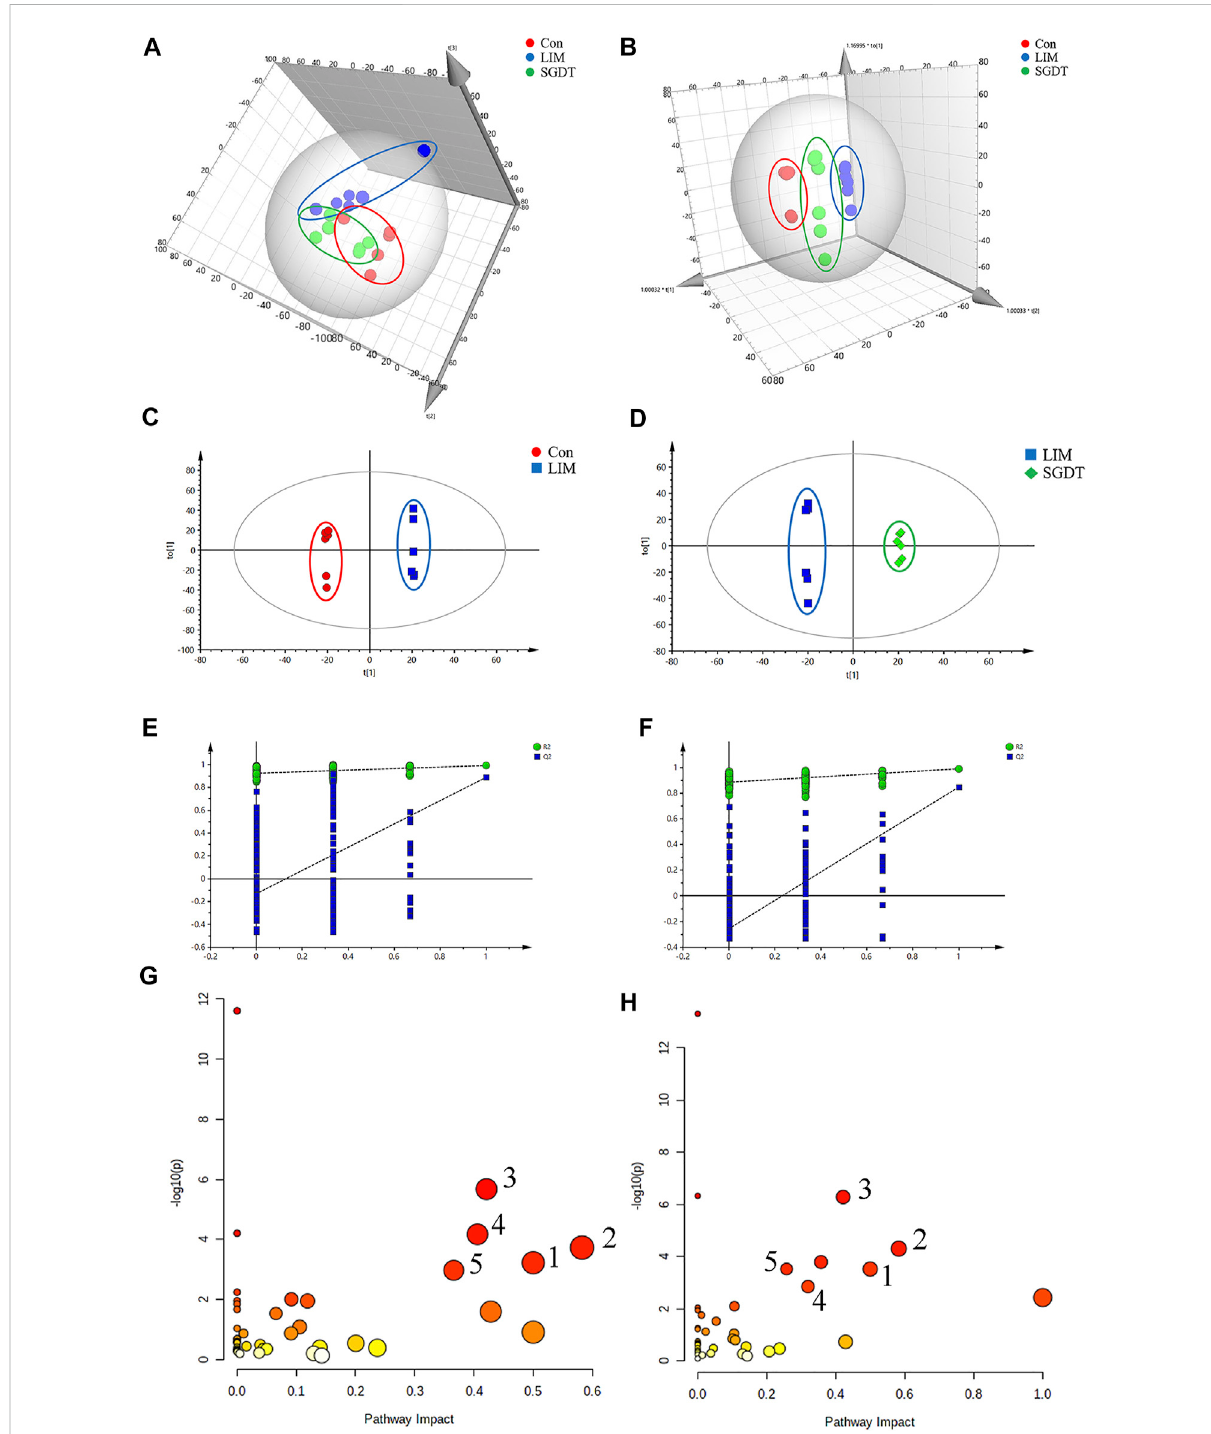
FIGURE 3 Fecal metabolite pro fi ling based on 1 H NMR spectrum of fecal samples, and metabolic pathways. (A,B) PCA and OPLS-DA score plots of Con, LIM and SGDT. (C,D) OPLS-DA score plots between Con and LIM, LIM and SGDT. (E,F) Permutation test plots (200 permutations) between Con and LIM ( R 2 = 0.925, Q 2 = -0.13), LIM and SGDT ( R 2 = 0.89, Q 2 = -0.227). (G,H) Signi fi cant metabolic pathways between Con and LIM, LIM and SGDT. (1) D -Glutamine and D-glutamate metabolism, (2) Alanine, aspartate and glutamate metabolism, (3) Arginine biosynthesis, (4) Glycine , serine and threonine metabolism, (5)Arginine and proline